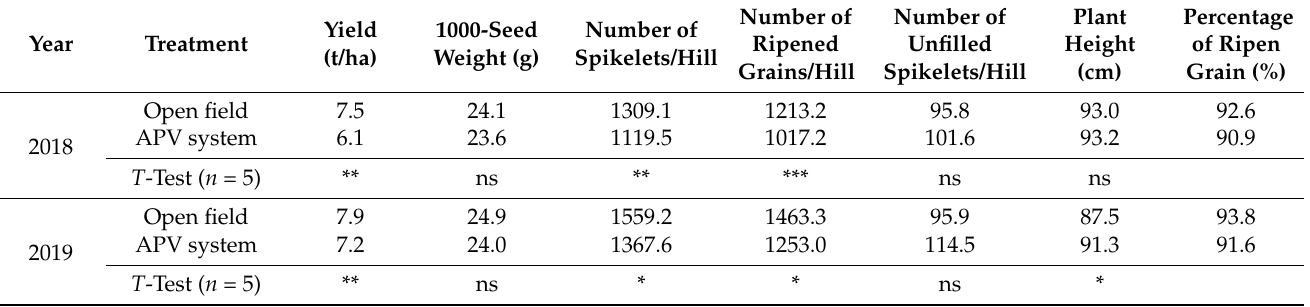
Table 1. Yield and yield component of rice between the agro-photovoltaic system and the open field over two